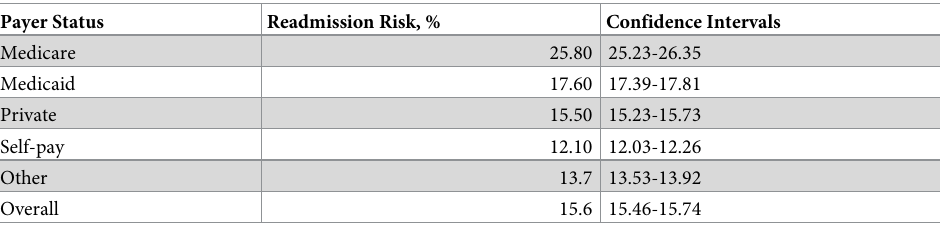
Table 3. 6-month readmission risk based on payer status at initial discharge.